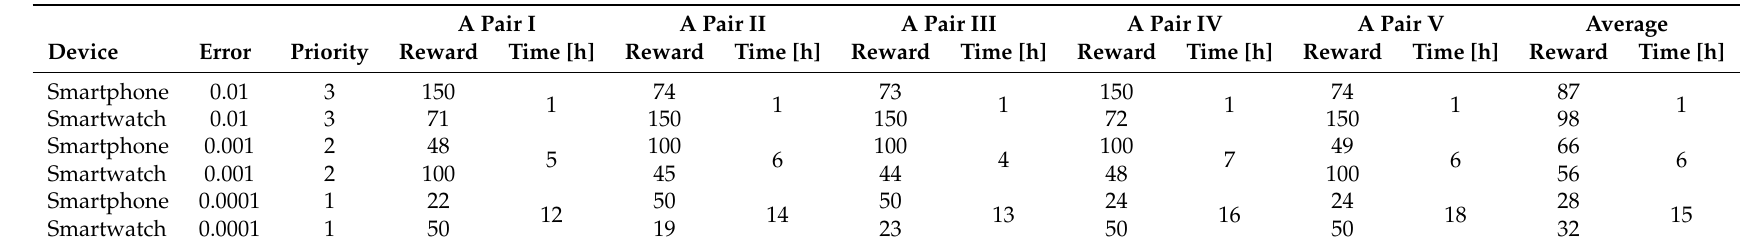
Table 1. Obtained results for a network composed of 2 hidden layers.